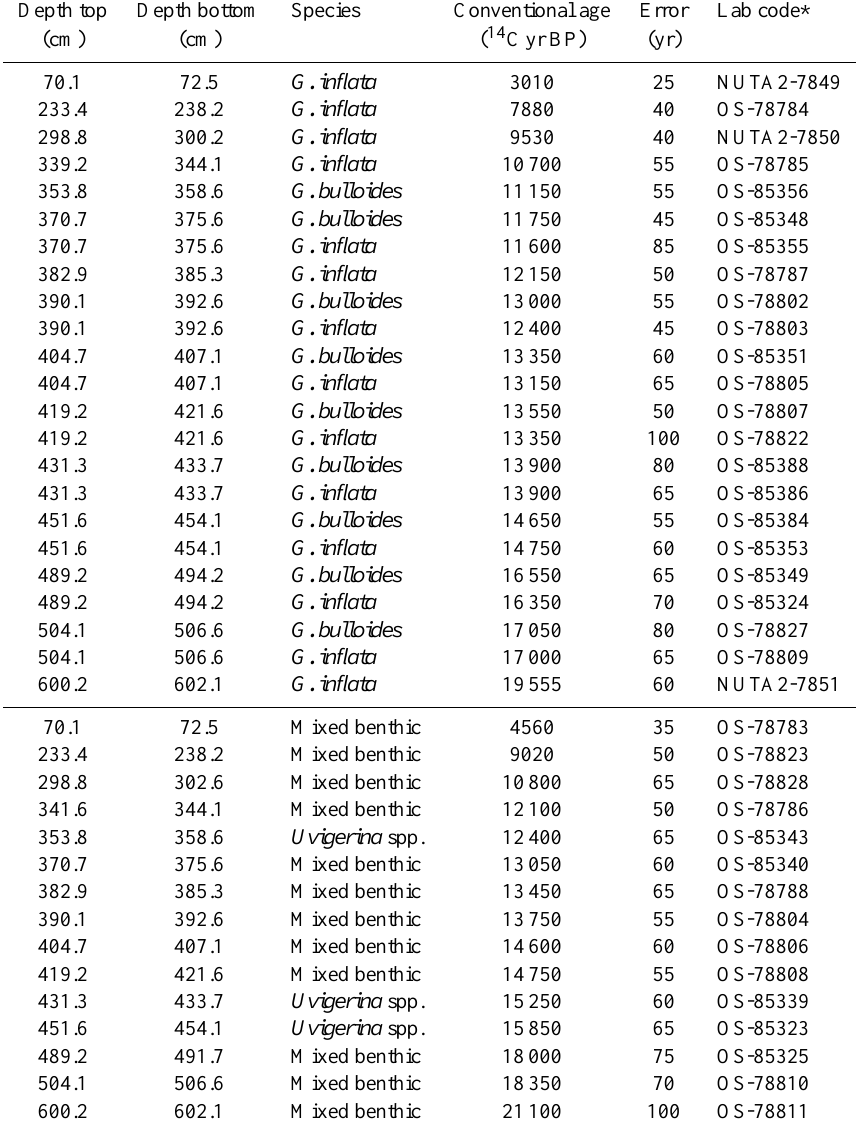
Table 2. Radiocarbon ages of planktic and benthic foraminifera in core MD01-2420. Errors are ± 1 σ . Depth